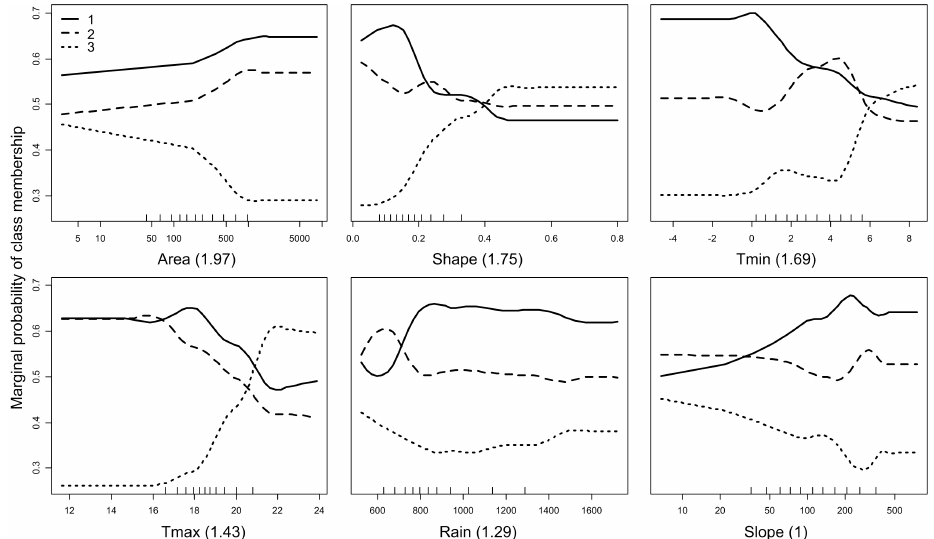
Fig. 11. Partial dependence plots for the three flow intermittence subclasses for the six environmental variables retained in the reduced model, in order of importance from the top-right to the bottom left. The plots show the marginal contribution to probability of class membership (y-axis) as a function of the variable (i.e., the other contributing variables were held at their mean). The rug plots on the horizontal axes show deciles of the predictors. The value in brackets on the horizontal axis is the importance